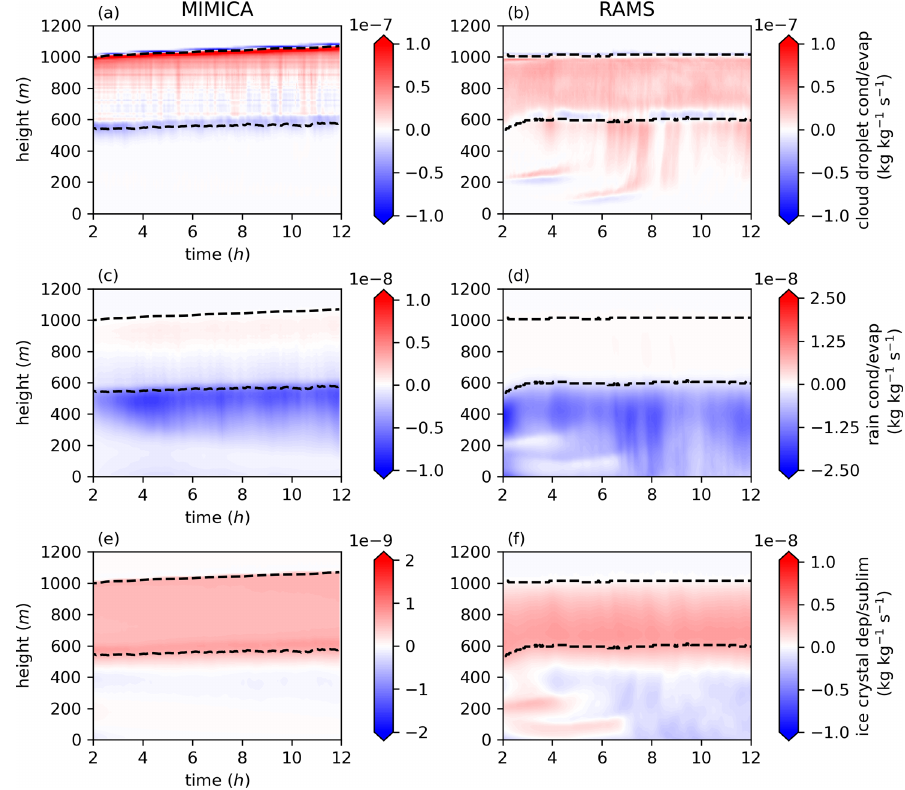
Figure 4. Cloud diagnostics simulated by MIMICA and RAMS for the baseline simulation, i.e. with accumulation and Aitken mode con- centrations of 20cm − 3 . (a, b) Cloud droplet condensation/evaporation rates, (c, d) raindrop condensation/evaporation rates and (e, f) ice crystal deposition/sublimation rates. The first 2h of simulations, considered as the spin-up period, are excluded. Red shading indicates net condensation and net deposition, while blue shading indicates net evaporation and net sublimation. Black dashed lines represent the cloud top and cloud base